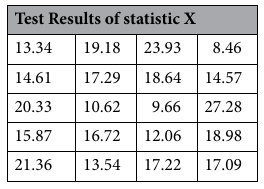
Table 3. The results of 20 times of Poker test.